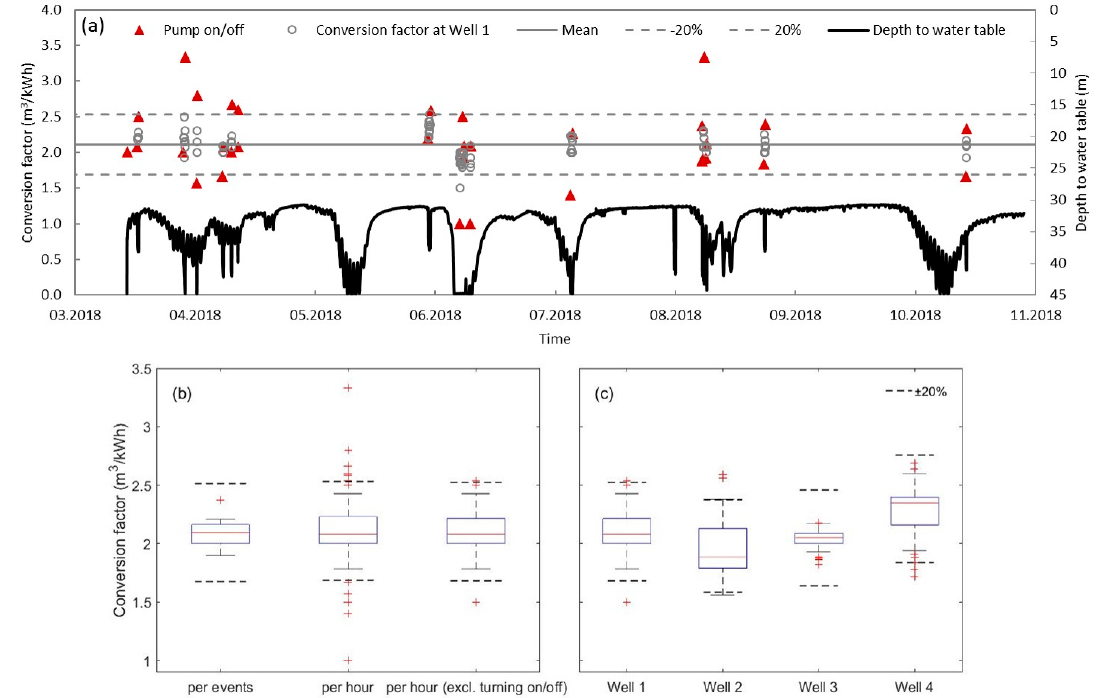
Figure 4. Conversion factors at wells. ( a ) Time series of conversion factor and depth to groundwater table at Well 1. The measurements at the times of turning the pump on or off are marked as triangles. (The dipper of the water level meter could only reach a depth of 45 m below ground level). ( b ) Boxplots of conversion factors at Well 1. ( c ) Boxplots of conversion factors at Well 1 to Well 4 excluding the data points when turning the pumps on or off. Outliers are data points beyond the first and third quantile by 1.0 times the interquartile range.